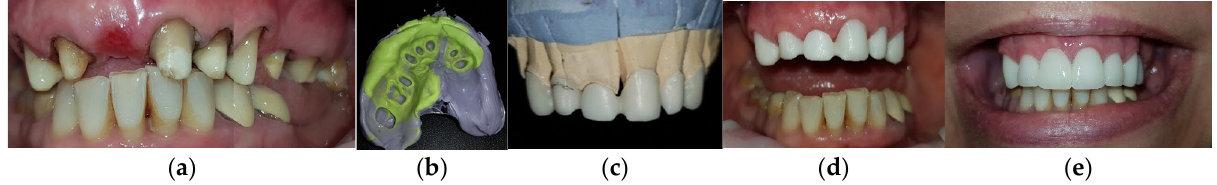
Figure 6. The steps of the prosthodontic rehabilitation: ( a ) Final aspect of the abutment after the healing period; ( b ) One-step impression with A silicone—Variotime Heavy Tray and Medium Flow (Zhermack); ( c ) The zirconia frame on the master cast; ( d ) The try-in of the zirconia frame; ( e ) The final restoration after cementation.